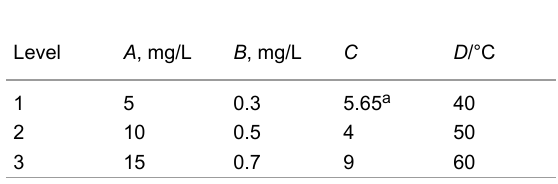
synthesis of ZnO. Eventually, we obtained five groups of CZO samples with different concentrations. For simplicity, samples with molar ratio of 0.5%, 1%, 2%, 3%, and 4% were named as CZO-1, CZO-2, CZO-3, CZO-4, and CZO-5, respectively.